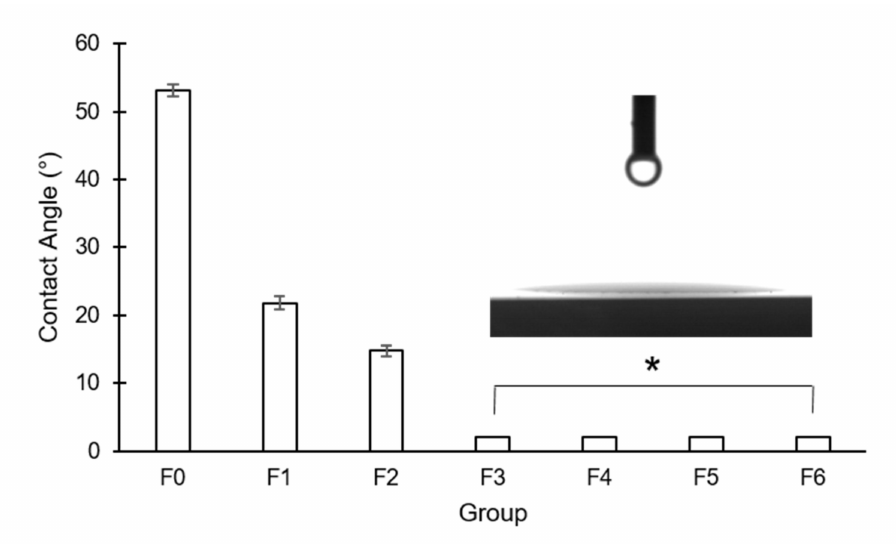
Figure 3. Measurement of contact angles of the experimental groups (F0–F6) (*: The values were less than 10 ◦ , indicating their hydrophilic